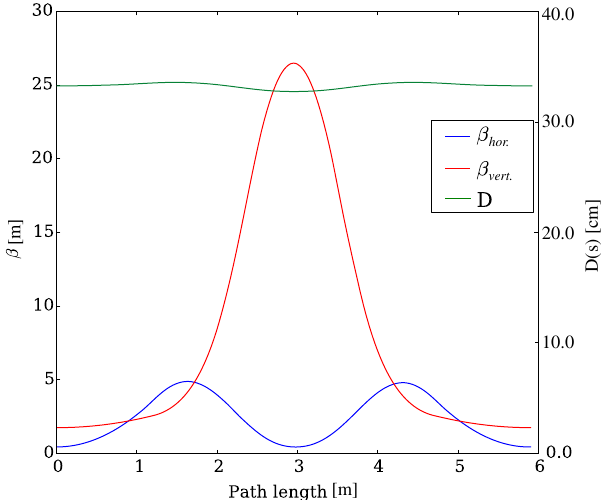
FIG. 8. The horizontal and vertical β -functions and the dispersion in the cell for the NORMA ring lattice are shown at the injection energy of 30 MeV.